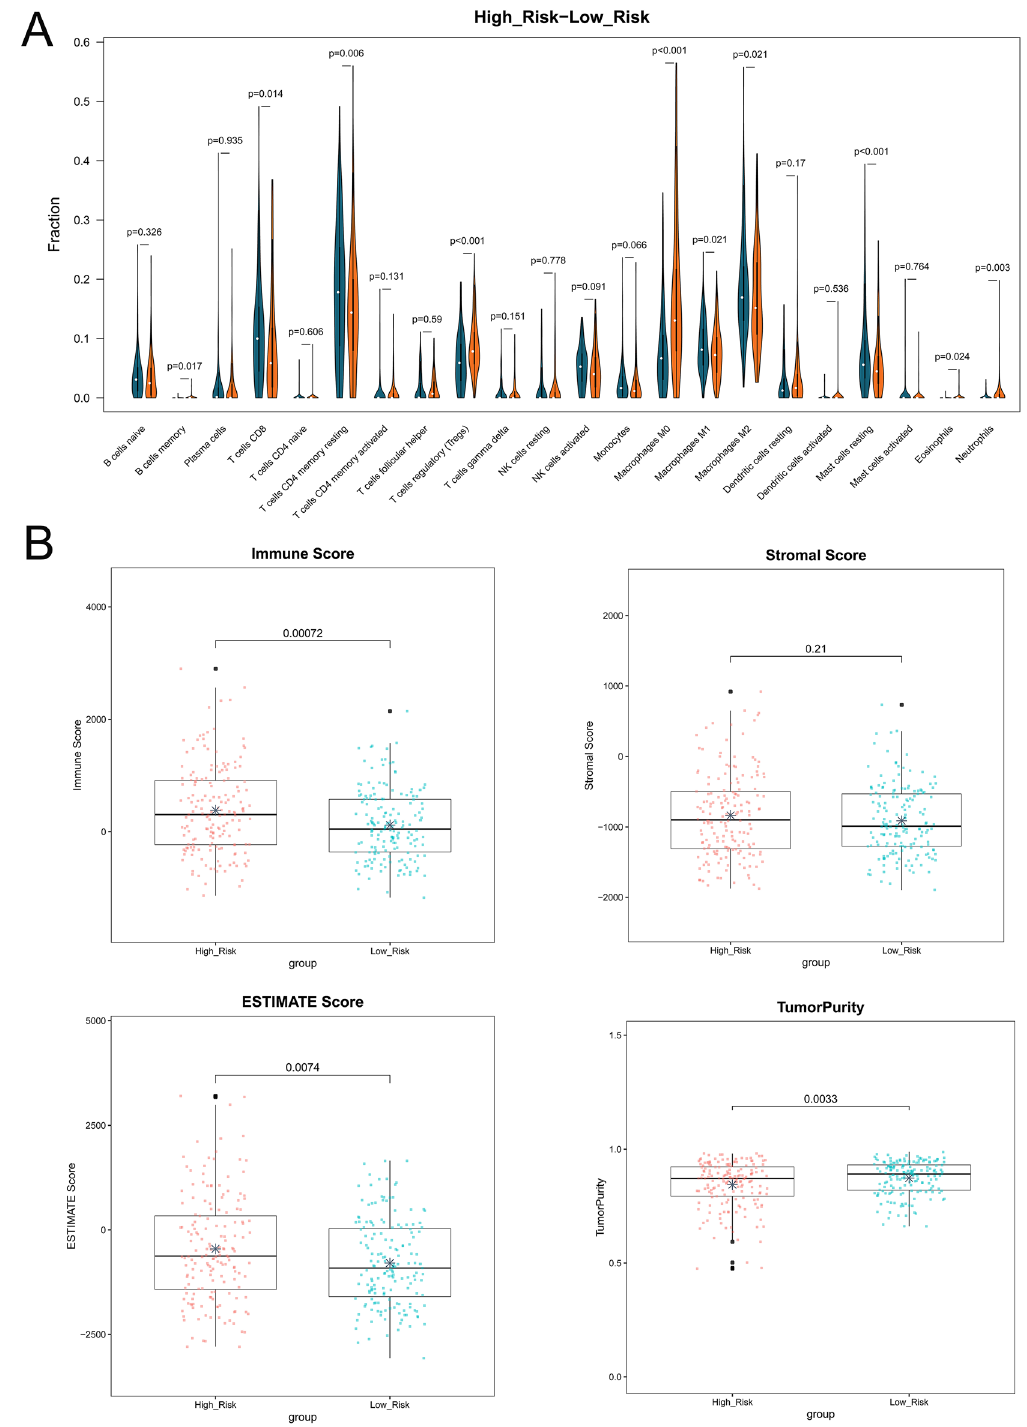
Figure 8. Tumor immune microenvironment. ( A ) The difference of tumor-infiltrating immune cells between risk groups. ( B ) The difference of immune score, stromal score, estimate score and tumor purity between risk groups. The stars in the boxplots represent mean